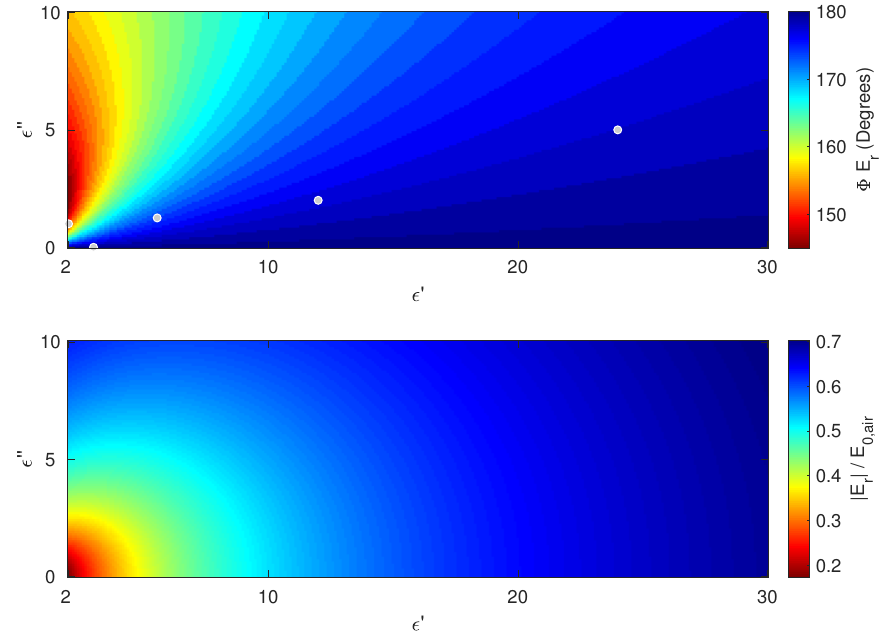
Figure 2. Phase ( top ) and amplitude ( bottom ) of the reflected E field E r , relative to the incoming signal ( E 0, air ), for a range of complex permittivities ( ε r (cid:48) and ε (cid:48)(cid:48) ) of bare soil: permittivities of Table 1 are plotted as gray circles in the top-left image.